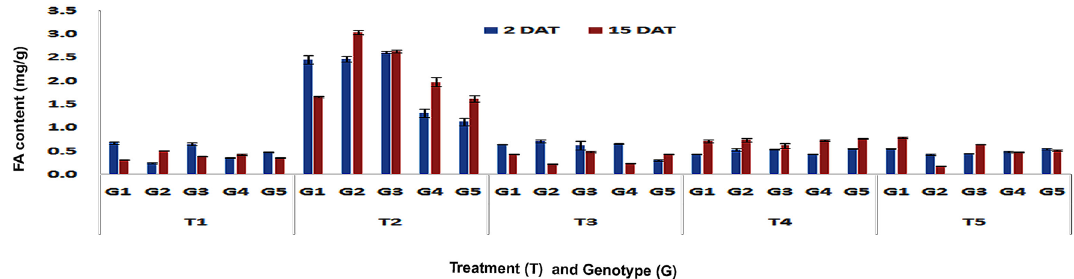
Figure 6. Changes in FA content in leaf tissues of maize genotypes to induced treatments in short (2 DAT) and long (15 DAT) term responses on the imposition of treatments at V6 stage (G1: DMRE 63; G2: CM 500; G3: WNZ Exoticpool; G4: CM 202; G5: BML 6; T 1 : Control; T 2 : PSB feeding; T 3 : Wounding; T 4 : Combination of wounding plus regurgitation; T 5 : Exposure to methyl jasmonate).